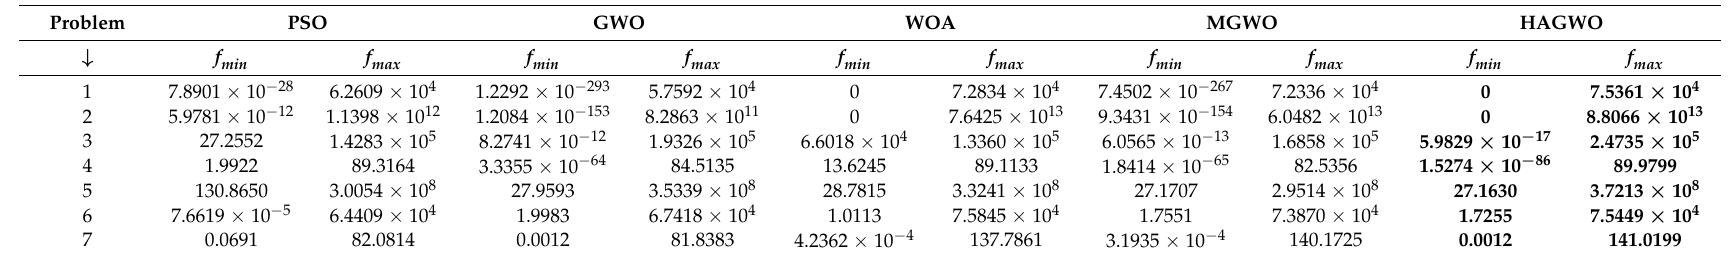
Table 4. Numerical results of unimodal benchmark functions.